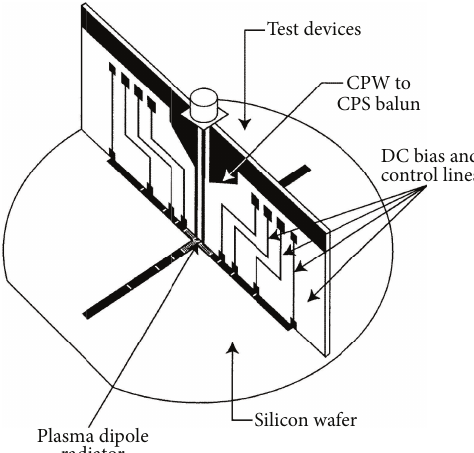
Figure 19: Monolithic dipole on a silicon wafer [35].